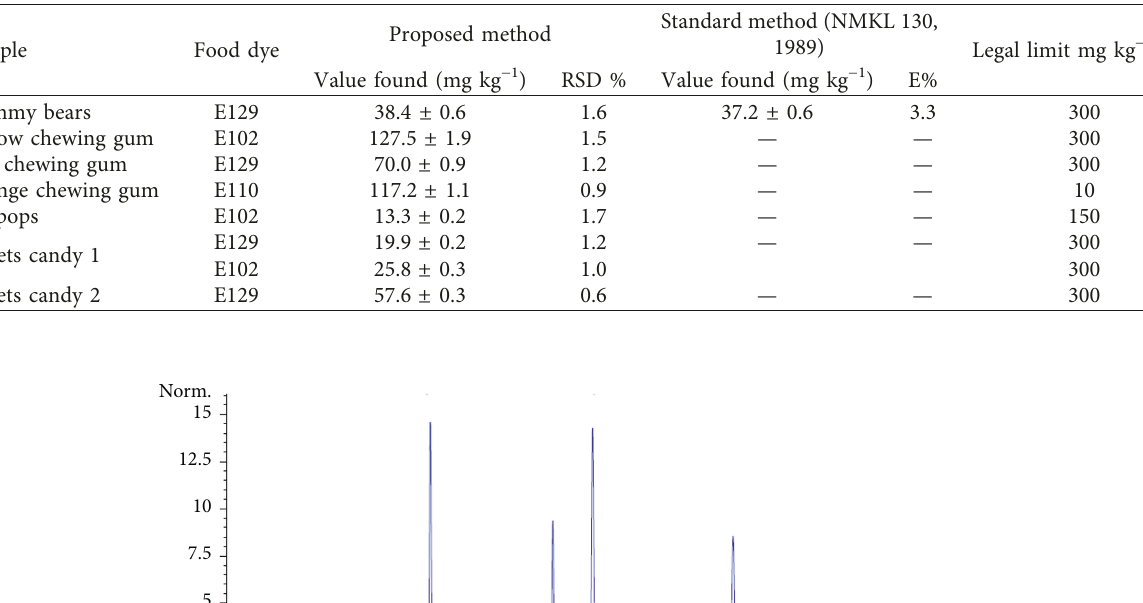
Table 2: Determination of the synthetic dyes in food samples ( N � 3).